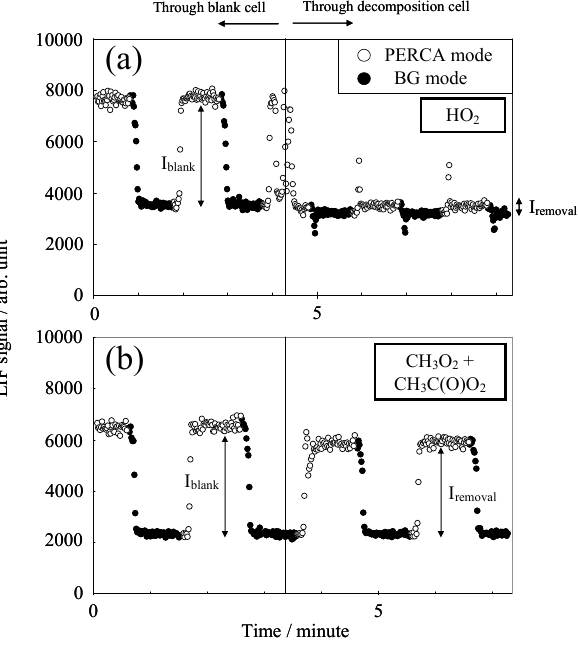
Fig. 2. An example of removal efficiency measurements showing PERCA/BG mode for both blank (left side) and removal (right side) mode. PERCA/BG mode are switched every minute. Upper panel (a) shows HO 2 , lower panel (b) is CH 3 O 2 +CH 3 C(O)O 2